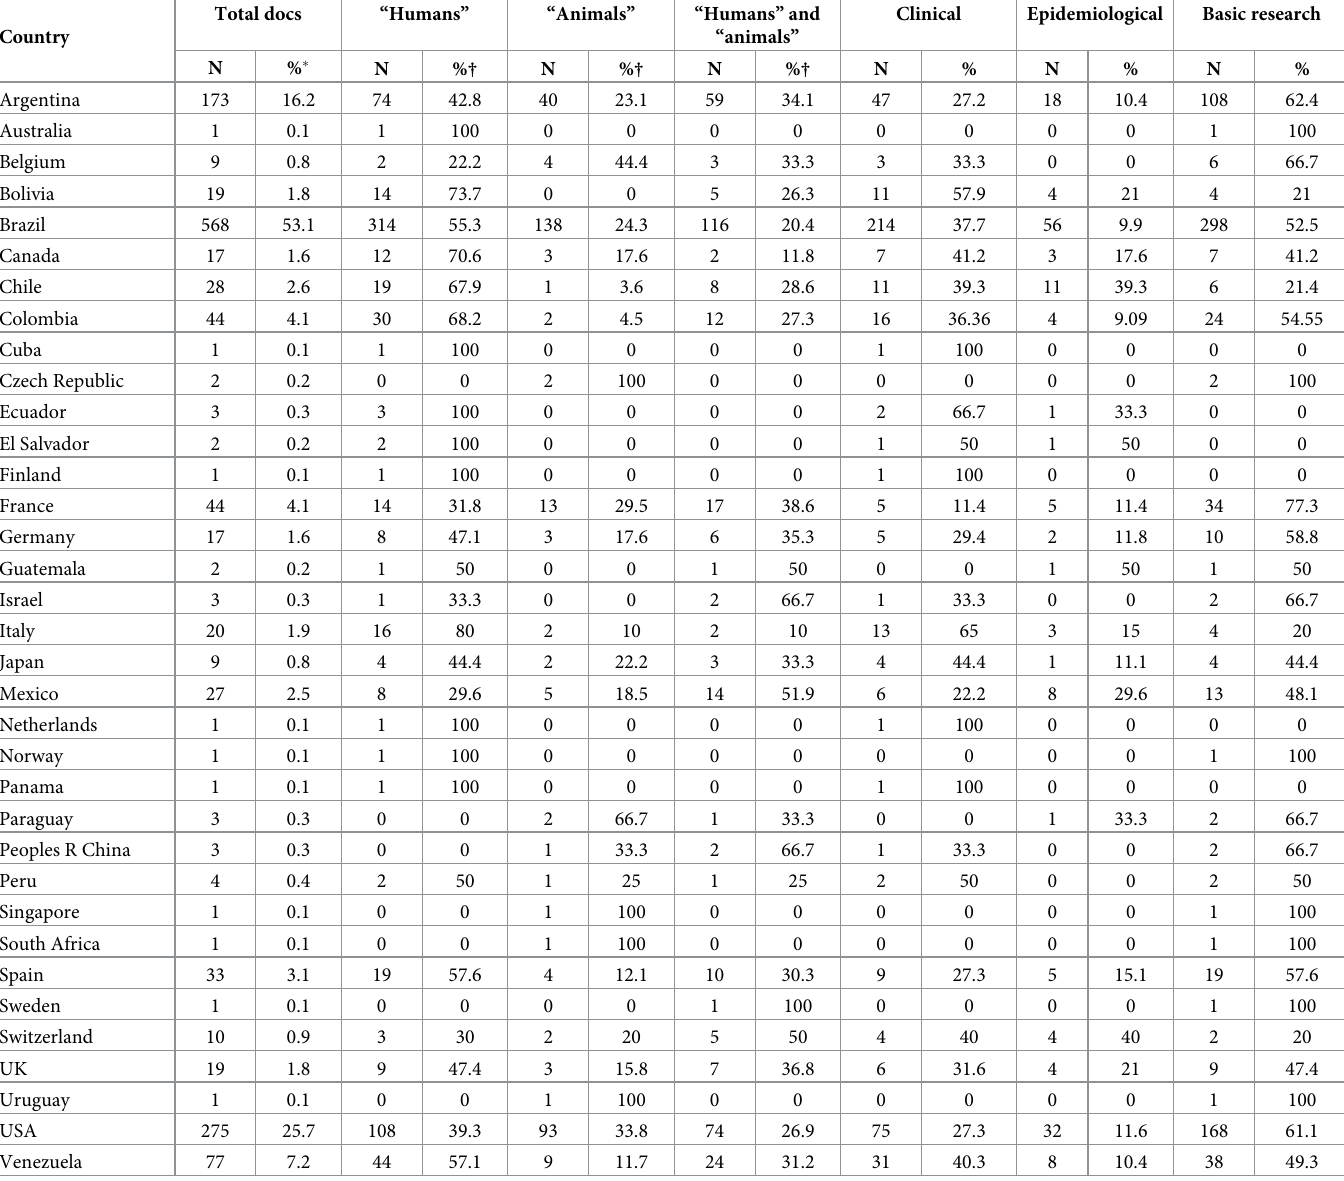
Table 4. Distribution by country of Chagas cardiomyopathy records indexed in SCI-Expanded, and number and % of documents containing the MeSH descriptors “humans” and “animals”. Total Country